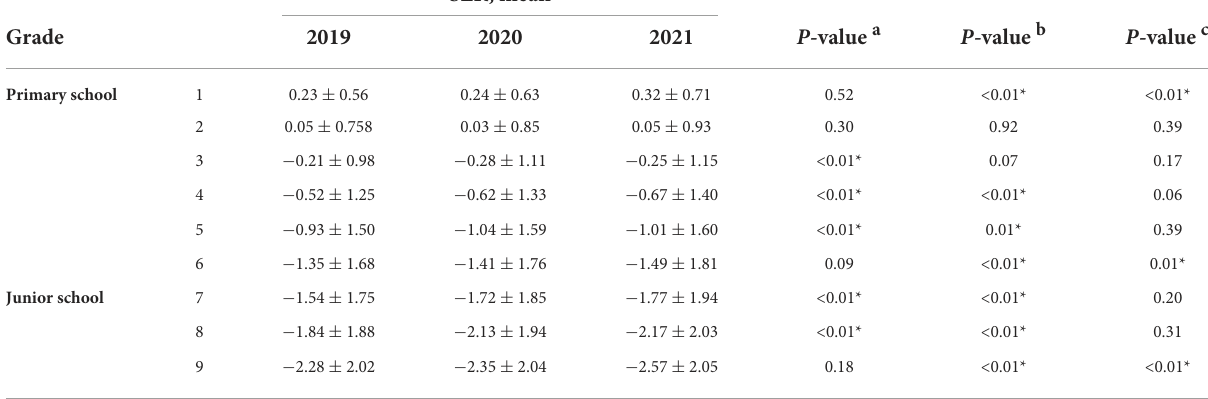
TABLE 2 SER values from grades 1 to grade 9 over the 3 years.